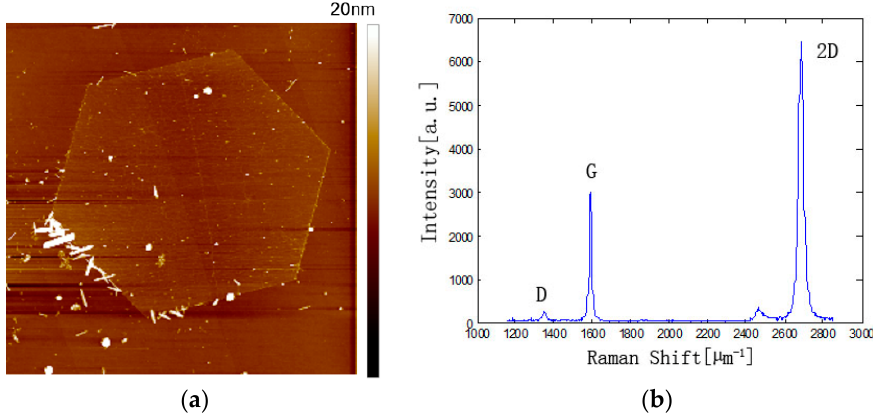
Figure 1. ( a ) Height image of the graphene in AFM tapping mode. Scan size: 30.0 µm × 30.0 µm; ( b ) Raman spectroscopy measurement of the intensity of the D and G peaks on the graphene layer in (a). The D, G and 2D Raman peaks for the graphene are labeled.